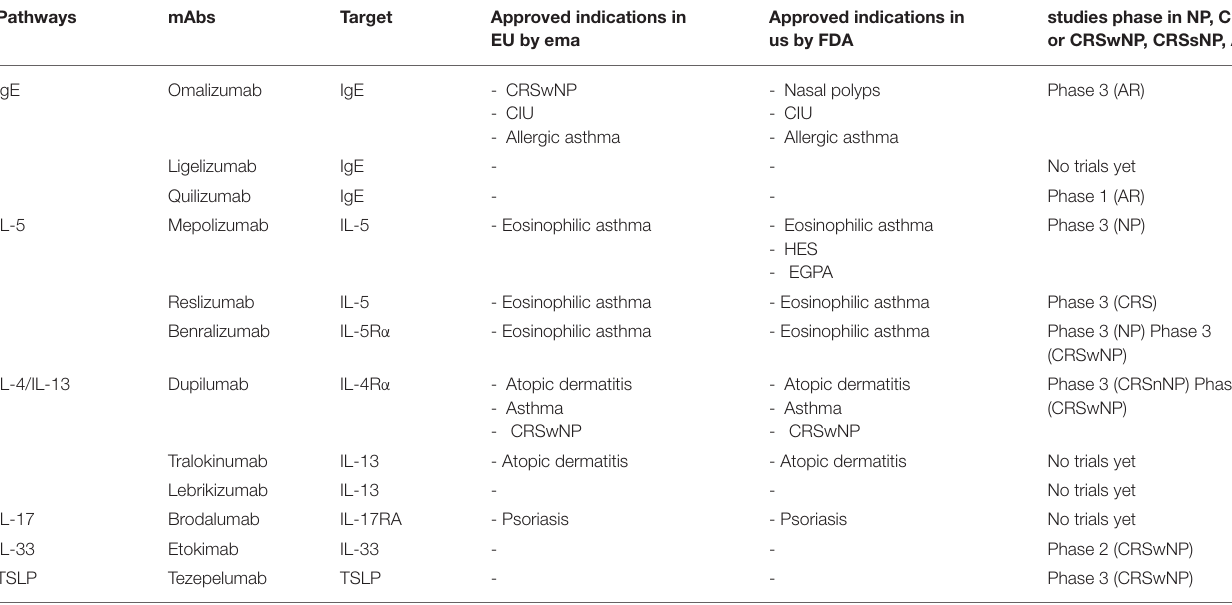
TABLE 1 | Main pathways target of recent innovative pharmacological treatments, their approved indications in Europe and United States and study phase for other inflammatory/infective sinonasal conditions. Pathways